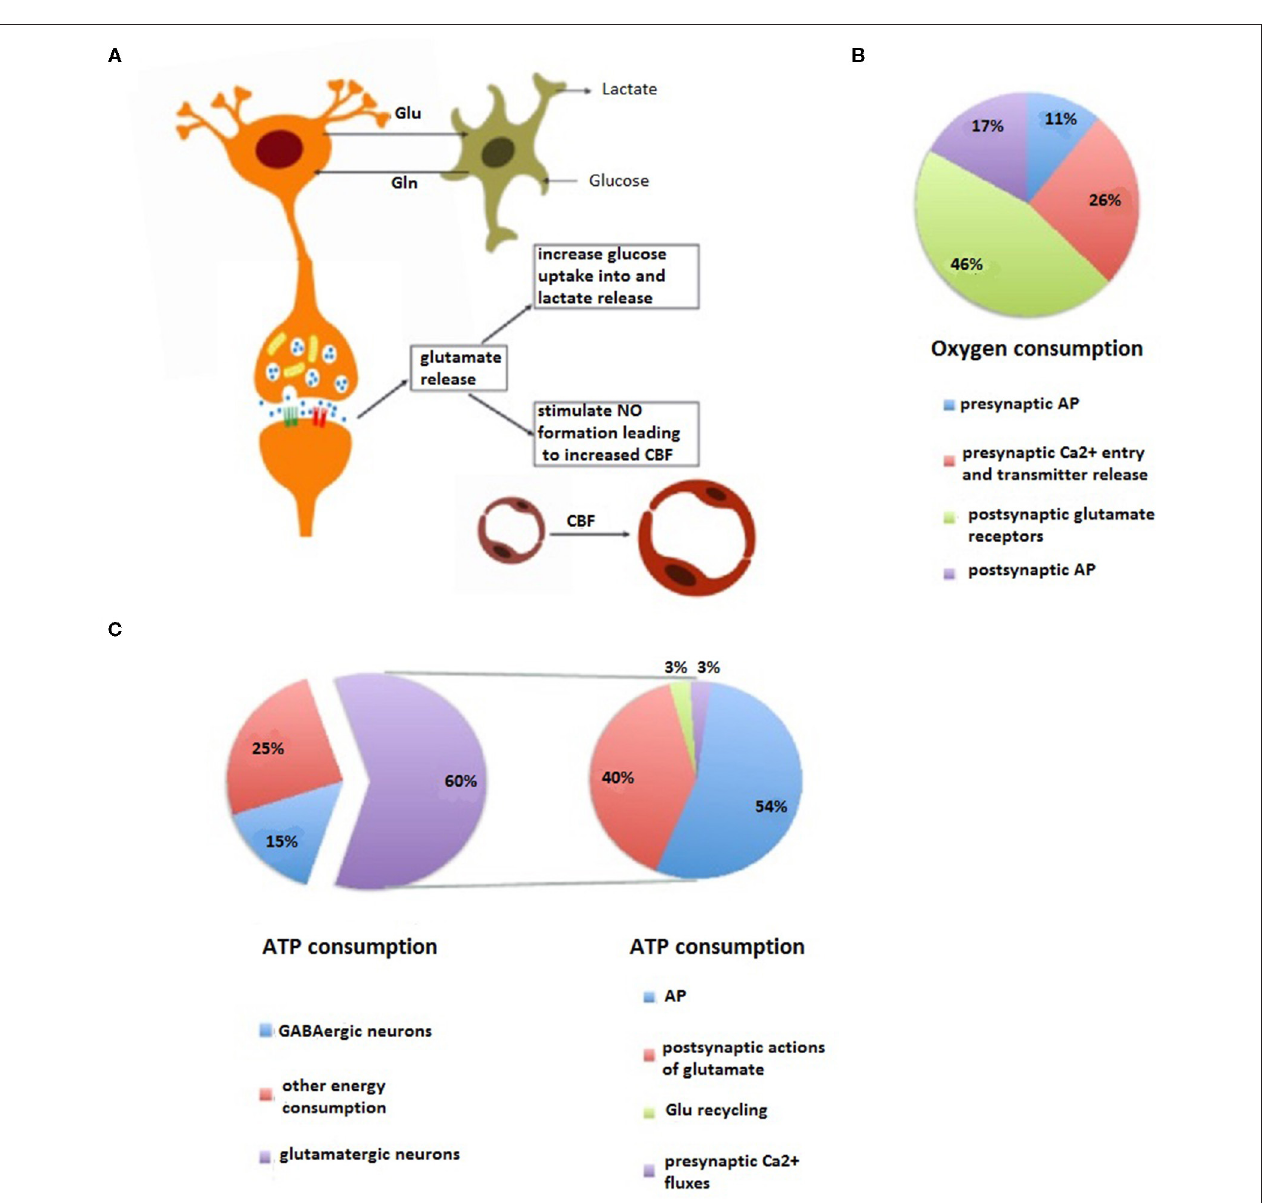
FIGURE 2 | Energetic and oxygen costs and coupling of neural processing. (A) Neurovascular and neurometabolic coupling. Physiological changes in the neural activity of the brain are invariably accompanied by changes in local blood flow and glucose utilization. During the modality-specific activation of a brain region, glutamate release from active synapses induces the increase of glucose use and lactate production of perivascular astrocytes and an increase in cerebral blood flow (CBF) through receptor-mediated nitric oxide (NO) formation. These activity-dependent processes help neurons to meet their energy needs. (B) Pharmacological analysis reveals an energy budget in which 11% of O 2 use is on presynaptic action potentials (APs), 17% is on presynaptic Ca 2 + entry and transmitter release, 46% is on postsynaptic glutamate receptors, and 26% is on postsynaptic APs, is approximately accordance with theoretical brain energy budgets. (C) Most of neurons and synapses (90%) in the cerebral cortex are either glutamatergic or gamma-aminobutyric acid-ergic (GABAergic) while 75% of the total cortical energy consumption is coupled to glutamate (60%) and GABA neurotransmitter cycling (left). Specially, the energy consumption used for glutamatergic neurotransmission (right) includes various neuronal components underlying the neural activity: presynaptic AP, entry of presynaptic Ca 2 + ions, neurotransmitter recycling (release, uptake, conversion, and storage in vesicles), and postsynaptic AP.